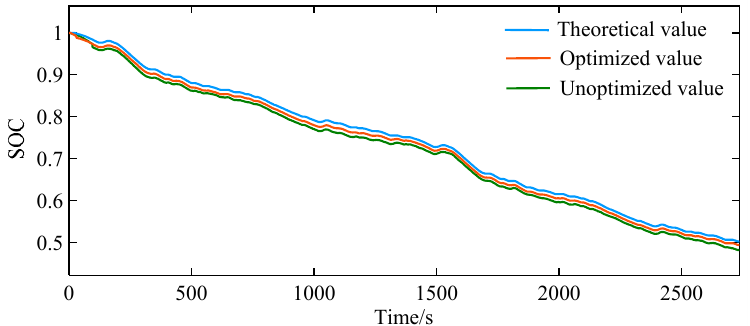
Figure 14. SOC estimation before and after optimization of the model parameters.